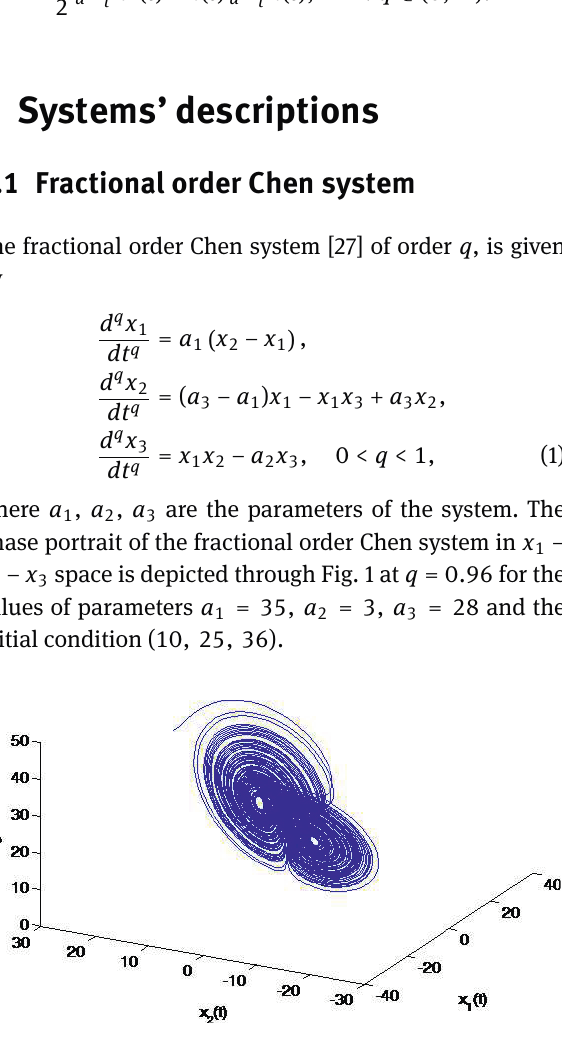
Fig. 1: Phase portrait of the Chen system in x 1 − x 2 − x 3 space at the order q =